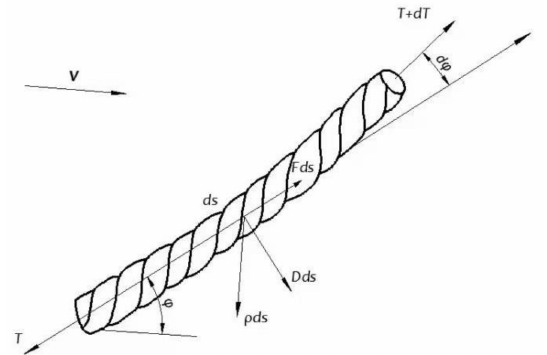
Figure 2. Diagram of cable micro-element